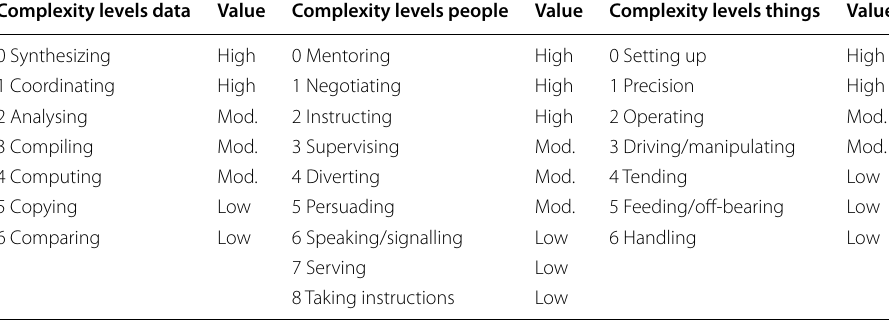
Table 7 DOT complexity measures Complexity levels data